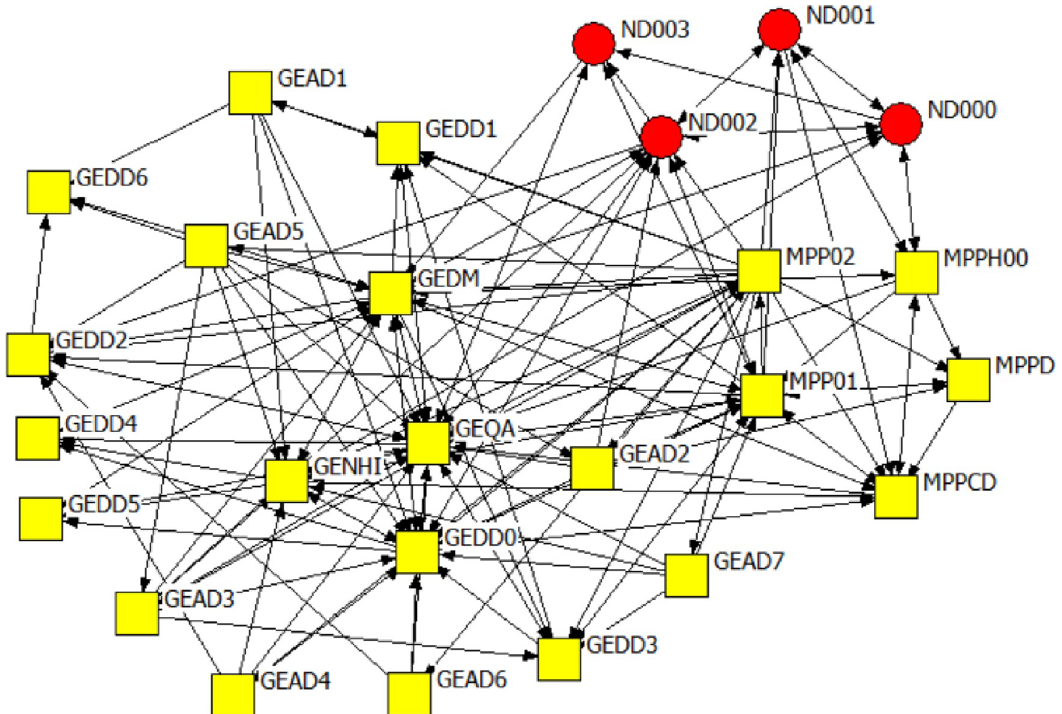
Fig 6. Mpumalanga province network: Seeking advice. Colour and Shape of the nodes: red circle = National, yellow square = Provincial. Nodes label: ND = A label starting with ND refers to national actors, MP & GE = A label starting with MP or GE refers to provincial actors.